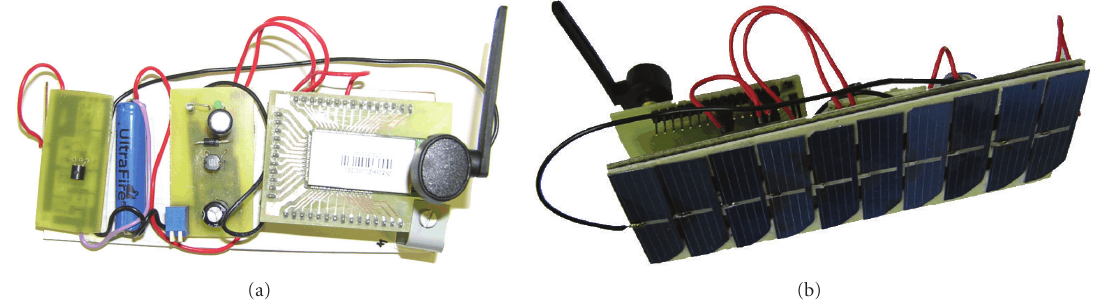
Figure 12: Alternative power supply source for wireless module from side of the solar panel (b) and printed circuit boards (a).